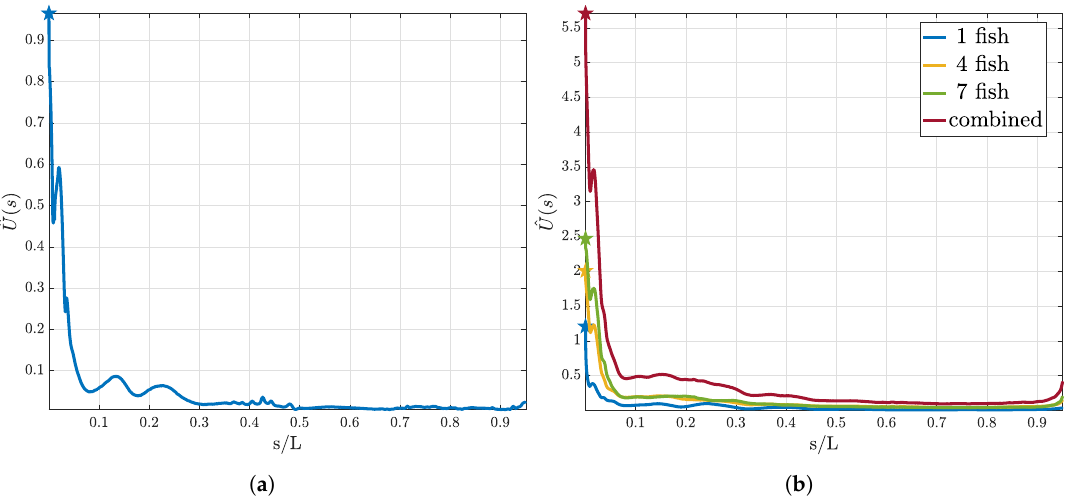
Figure 4. Utility curves for the first sensor using pressure measurements. In ( a ) the utility estimator for the “size of the leading school” experiment is presented. ( b ) corresponds to the utility estimator for the “relative position” experiment. We show the resulting curves for one, three and seven swimmer in the leading group and the total expected utility. We observe that although the form does not drastically change, the total utility increases with increasing size of the leading